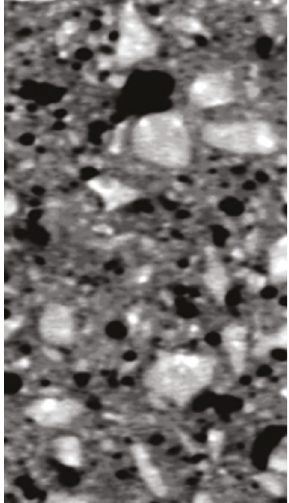
Figure 9: After extraction of the CT